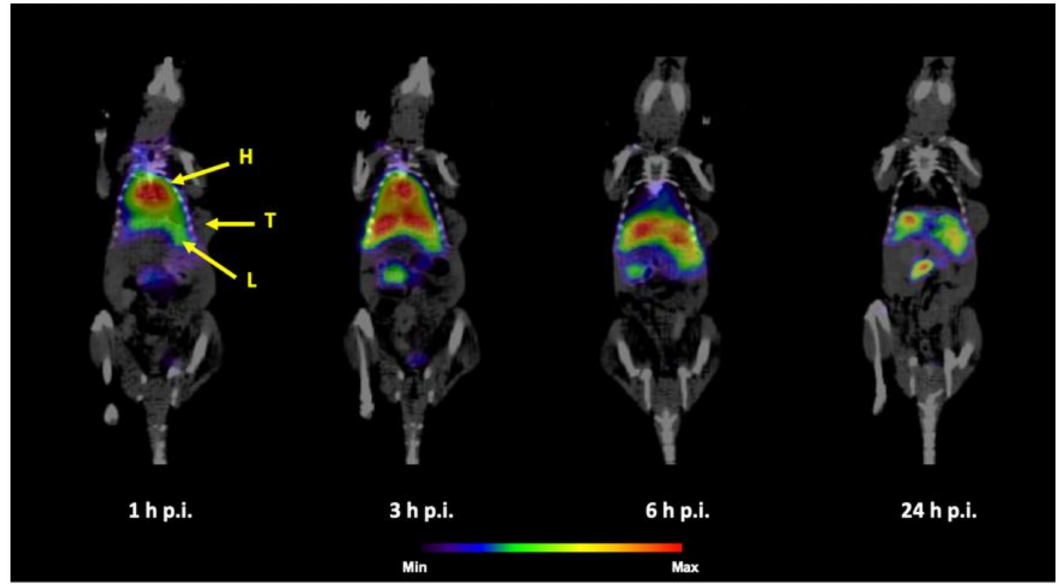
Figure 8. Coronal slices of SPECT / CT imaging of 99m Tc-PEG5000-HAP in HT-29 tumor-bearing mouse 1, 3, 6 and 24h p.i. after r.o. injection (H = heart, L = liver, T = tumor).